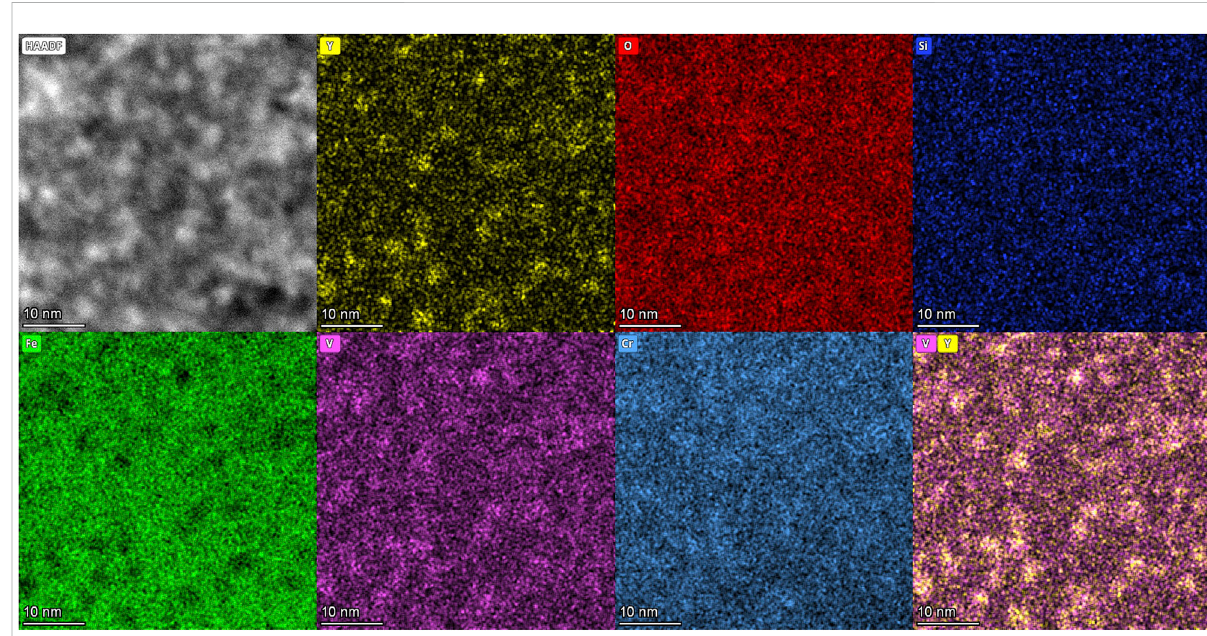
FIGURE 10 HADDF image and EDS elemental mappings of oxide nano-precipitates after irradiation, captured in the depth of 400 nm, corresponding to a damage of about 35 dpa.